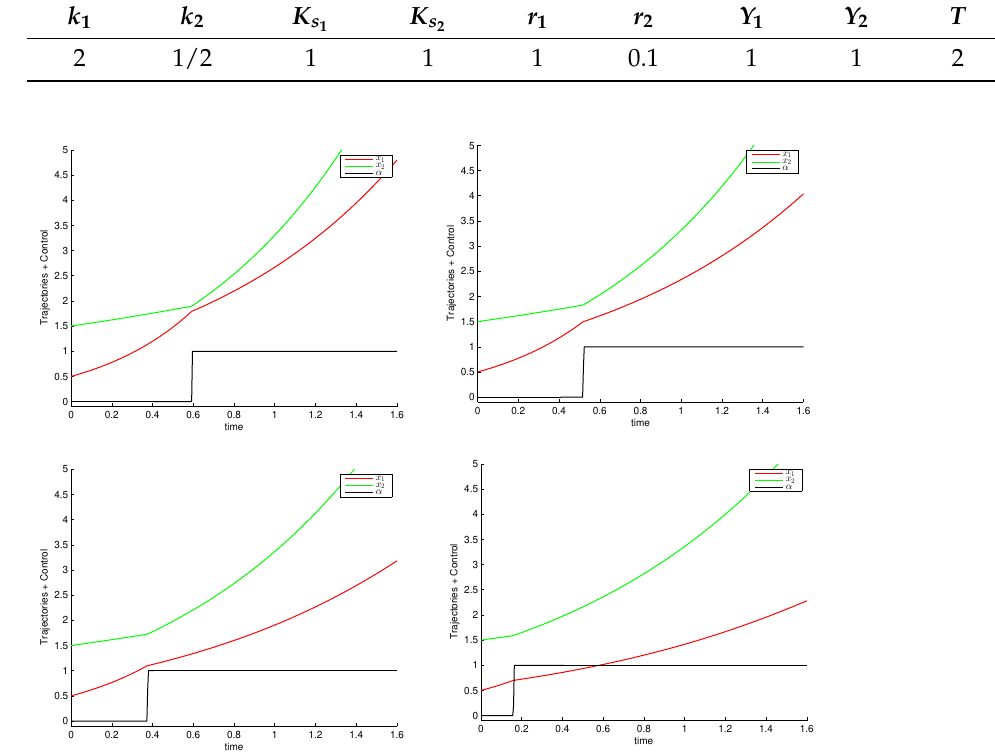
Table 2. Numerical values of the different parameters: case of Monod-type growth rates (3).